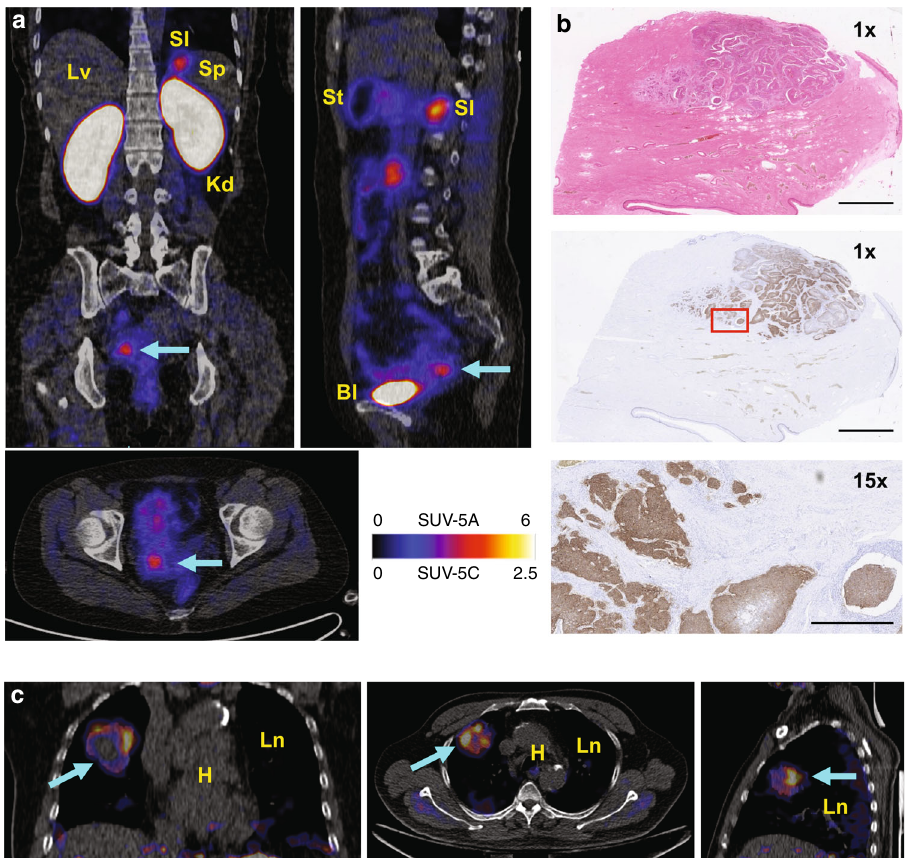
Fig. 5 [ 68 Ga]NODAGA-R 0 1-MG PET imaging of cervical cancer and lung cancer. a Coronal (top left), sagittal (top right) and axial (bottom left) planes of PET/CT images of a 47-year-old cervical cancer patient shows tracer accumulation in the tumor (cyan arrow). Bl, Kd, Lv, SI, Sp, and St refer to the bladder, kidneys, liver, small intestine, spleen and stomach, respectively. b H&E staining and IHC analysis con fi rm expression of integrin α v β 6 by the larger diffuse cancer cells. Integrin α v β 6 was not expressed by the normal cells of the cervix surrounding the tumor. Red box represents area shown at 15x magni fi cation in image below. Scale bars on the 1x and 15x images represent 2.5 cm and 250mm, respectively. c Coronal (left), axial (middle) and sagittal (right) planes of PET/CT Images of a 70-year-old patient diagnosed with poorly differentiated squamous cell carcinoma of the lung (SUV mean = 2.2). The cyan arrow points to the tumor. The healthy lung and heart are indicated by Ln and H,